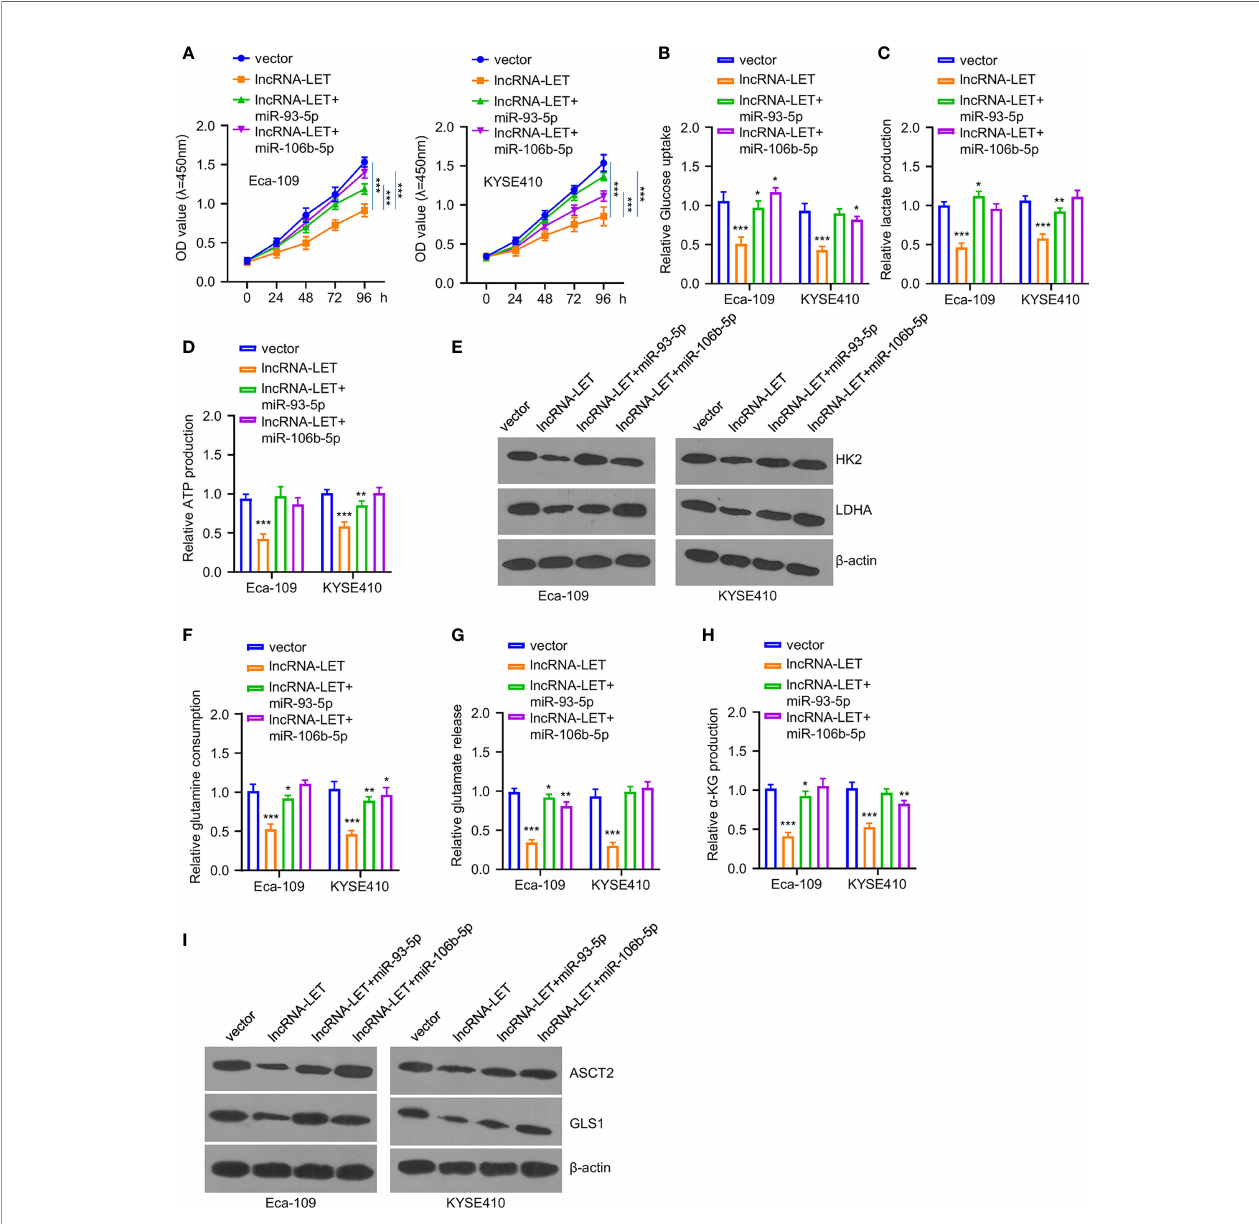
FIGURE 4 | (A) Cell viability in cells after lncRNA-LET transfection or lncRNA-LET and miR-93-5p or miR-106b-5p transfection was measured with CCK-8 kit. (B – D) Glucose consumption, lactate production, and ATP generation within cells after lncRNA-LET transfection or lncRNA-LET and miR-93-5p or miR-106b-5p transfection were de fi ned by a glycolysis kit. We performed Western blotting for detecting (E) hK2 and ldhA protein expression within cells after lncRNA-LET transfection or lncRNA-LET and miR-106b-5p or miR-93-5p transfection and (I) ASCT2 and gls1 protein levels within cells after lncRNA-LET transfection or lncRNA- LET and miR-106b-5p or miR-93-5p co-transfection. (F – H) The glutamine, glutamate, and a -KG levels within cells after lncRNA-LET transfection or lncRNA-LET and miR-106b-5p or miR-93-5p co-transfection were measured through a -KG detection kit. * P < 0.05, ** P < 0.01, and *** P <